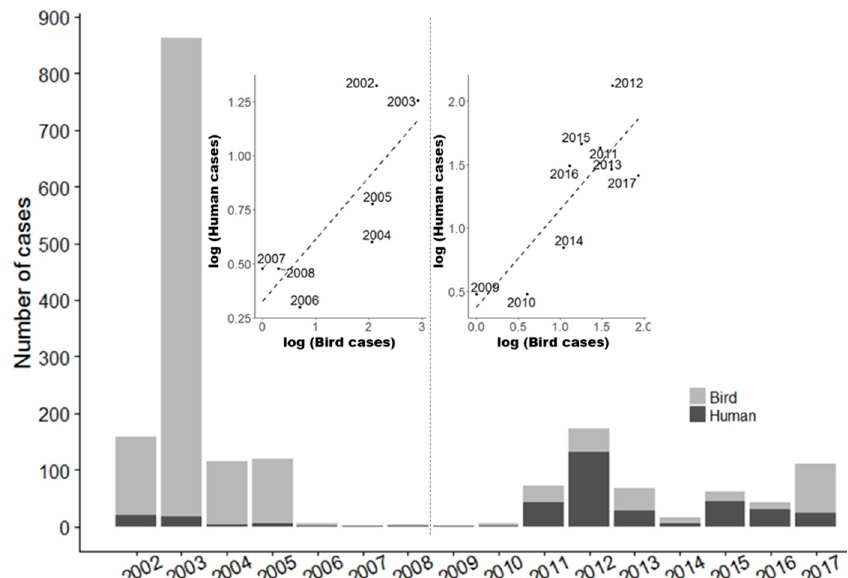
Figure 1. Yearly number of cases of West Nile virus (WNV) infection in humans and number of dead birds positive to WNV in Québec 2002–2017. Insert: Correlation between the number of WNV bird and human cases in Québec.